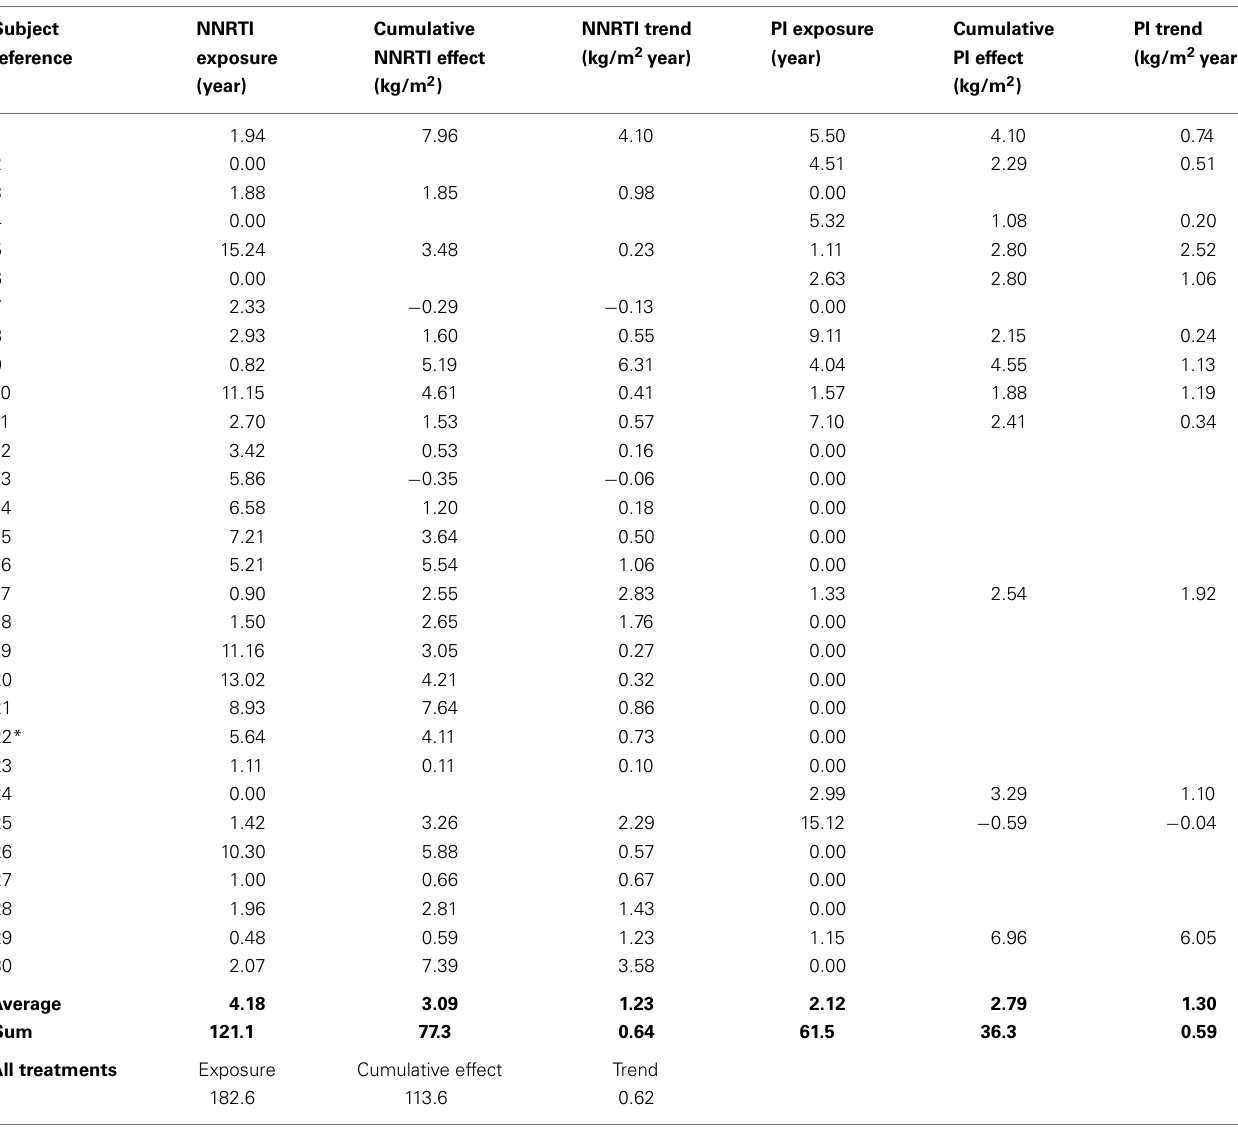
Table 1 |Weight trends of obeseAfrican women on cART by drug-class